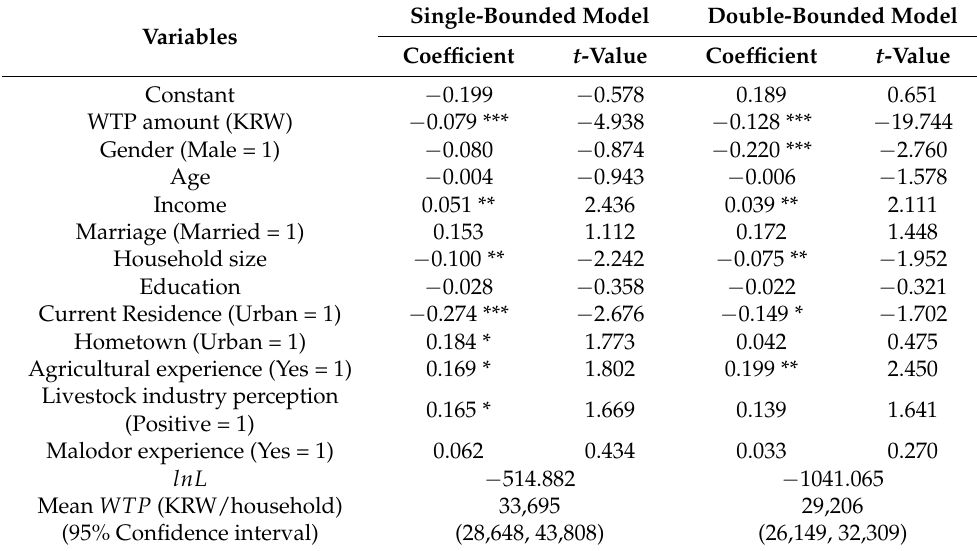
Table 3. Estimates of WTP for addressing malodor issue with explanatory